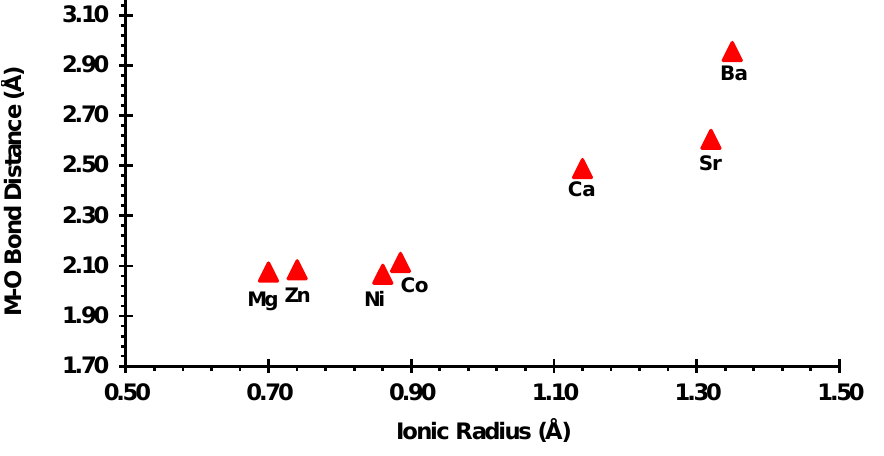
Figure 8. Dependence of M-O(H 2 O) bond lengths in divalent metal-aqua species on metal ionic radius.